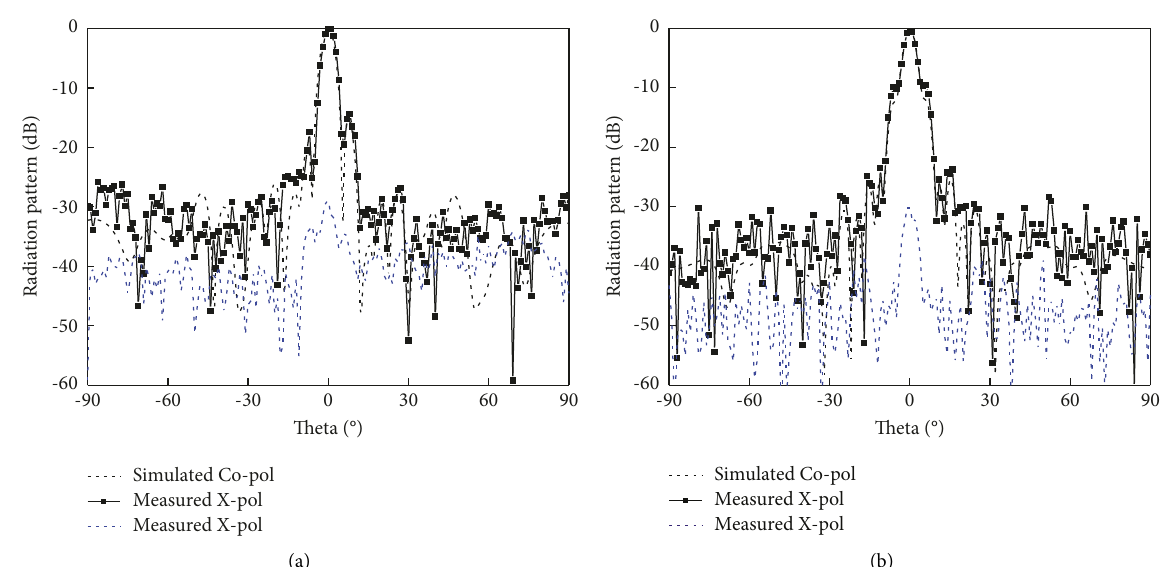
Figure 16: Normalized radiation patterns at 35.4 GHz. (a) E-plane. (b)